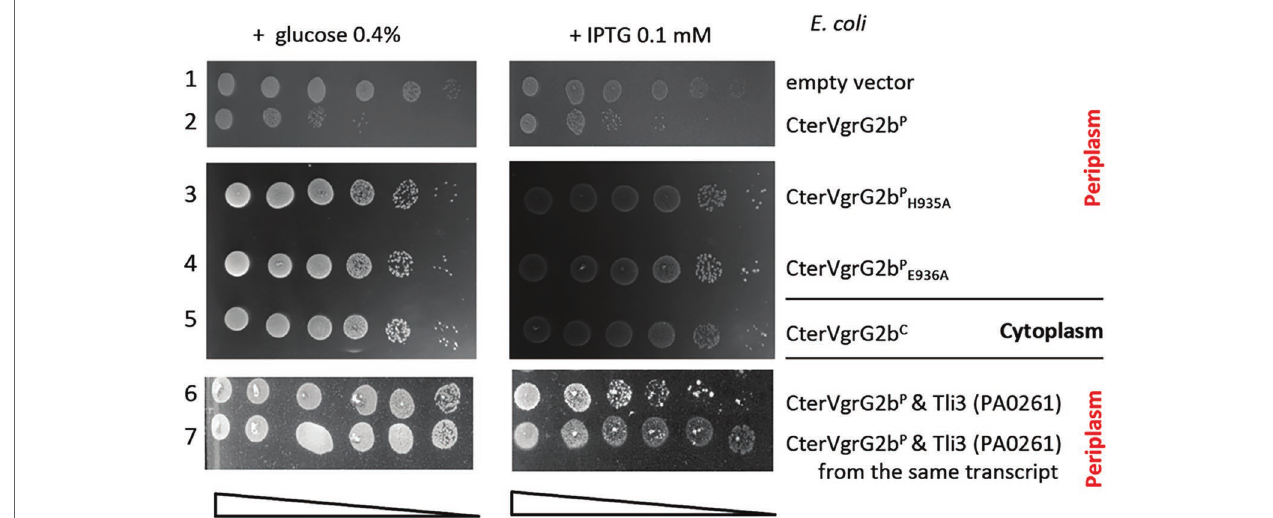
FIGURE 7 | The protease domain of VgrG2b is required for its antibacterial activity. Serial dilutions (from non-diluted to 10 −5 ) of normalized cultures of E. coli BL21(DE3)pLys producing the wild-type C-terminal domain of VgrG2b in the cytoplasm, called CterVgrG2b C (from pBB43, a pETDuet-1 derivative, line 5) or in the periplasm, called CterVgrG2b P (from pBB44, a pET22b(+) derivative yielding a fusion of the C-terminal domain with a Sec signal peptide, line 2) or two variants CterVgr2b P H935A (from pBB45, line 3) and CterVgr2b P E936A (from pBB46, line 4) were spotted on LB agar plates supplemented (left panel) with 0.4% glucose or (right panel) with 0.1 mM IPTG. In line 6, the CterVgrG2b P (from pBB44) was coproduced with Tli3 (from pVT8) and in line 7, the CterVgrG2b P and Tli3 were coproduced from the same transcript (from pSBC110). Glucose and IPTG allow respectively repression and induction of the gene encoding the T7 RNA polymerase.